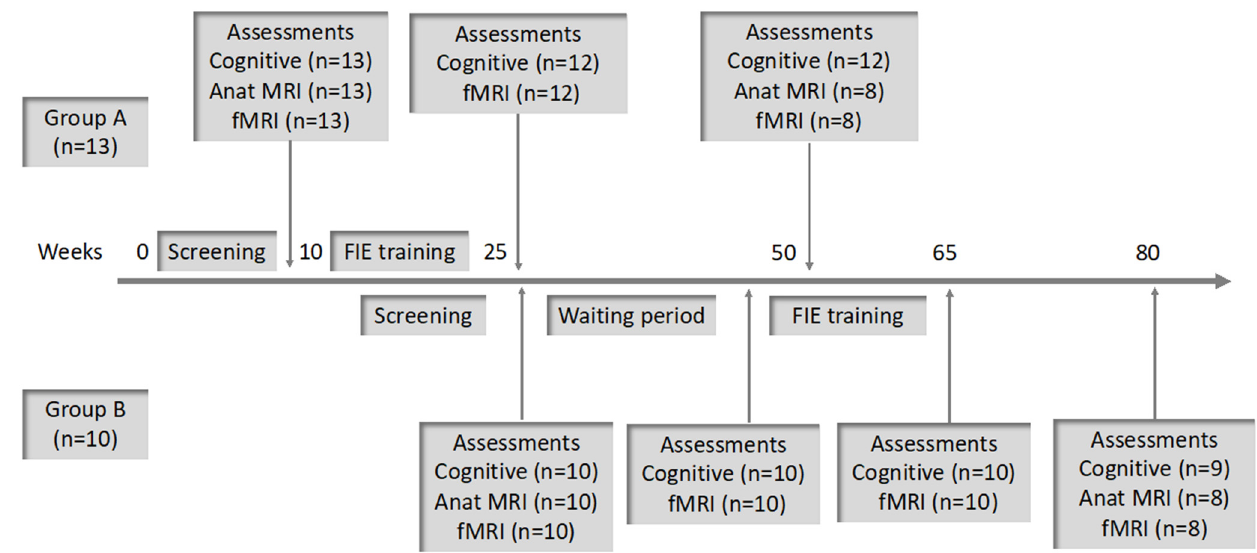
Figure 1. Timeline of study assessments and intervention according to groups. Abbreviations: Anat MRI—Anatomic Magnetic Resonance Imaging; fMRI = Functional MRI; FIE—Feuerstein Instrumental Enrichment.